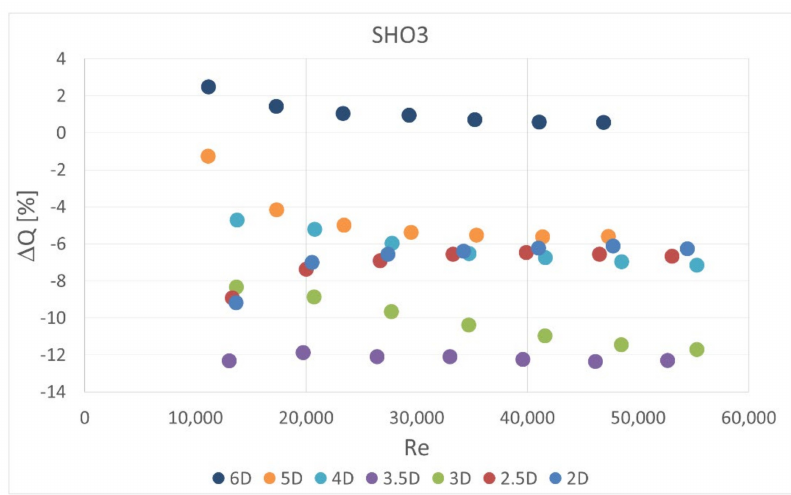
Figure 18. Measurement error of mass flow rate in SHO3 for disturbed